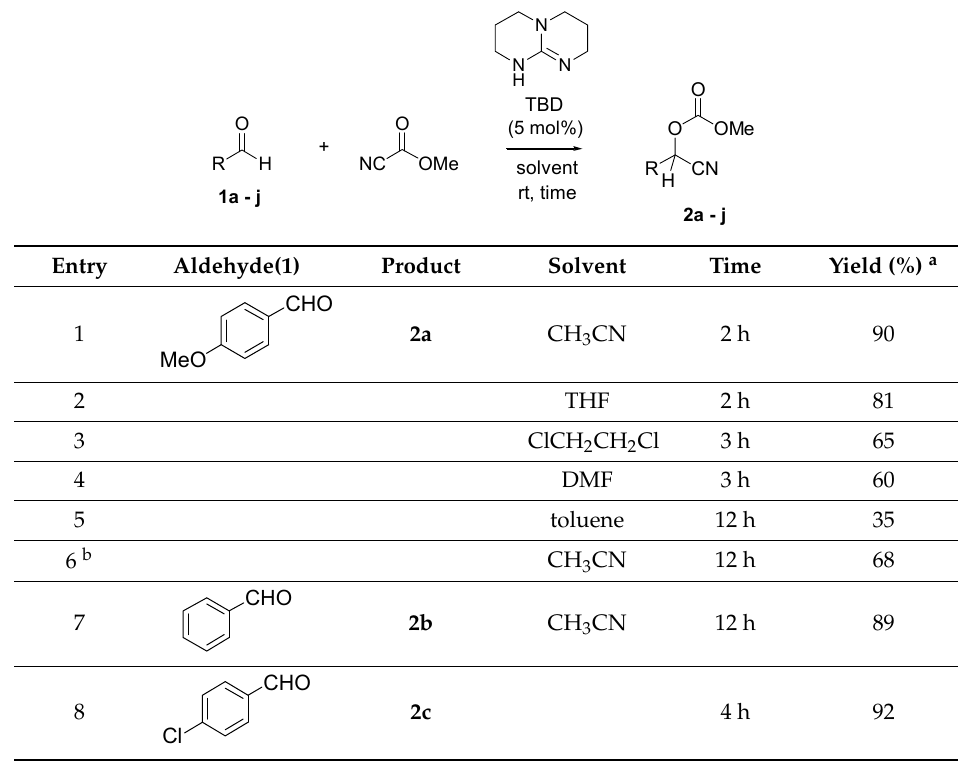
Table 1. Table 1. TBD (1,5,7-triazabicyclo[4,4,0]dec-5-ene) catalyzed cyanation of aldehydes with methyl cyanoformate.